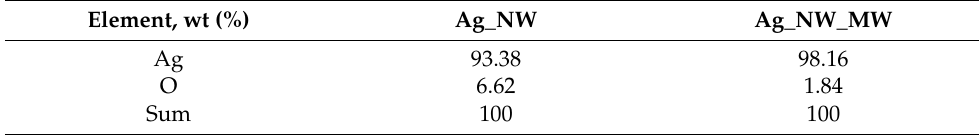
Figure 7. AFM-image of morphology of silver nanowires obtained by adding K 4 Fe(CN) 6 . The data of the energy dispersion analysis (Table 1) indicate that the element concen- trations during the synthesis procedure and in the obtained material are the same. Table 1. Properties of the sintered specimens.